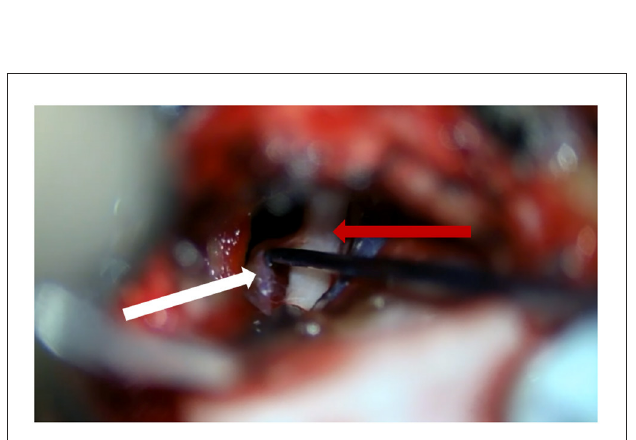
FIGURE4 The SCA (white arrow) compresses the trigeminal nerve (red arrow). SCA, superior cerebellar